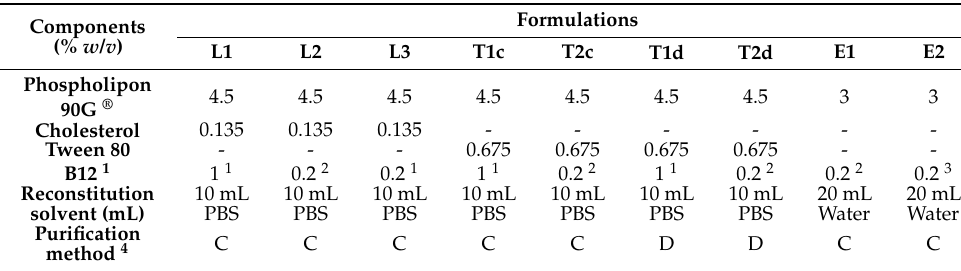
Table 1. Quantitative composition of the different lipid vesicle systems, reconstitution conditions, and purification